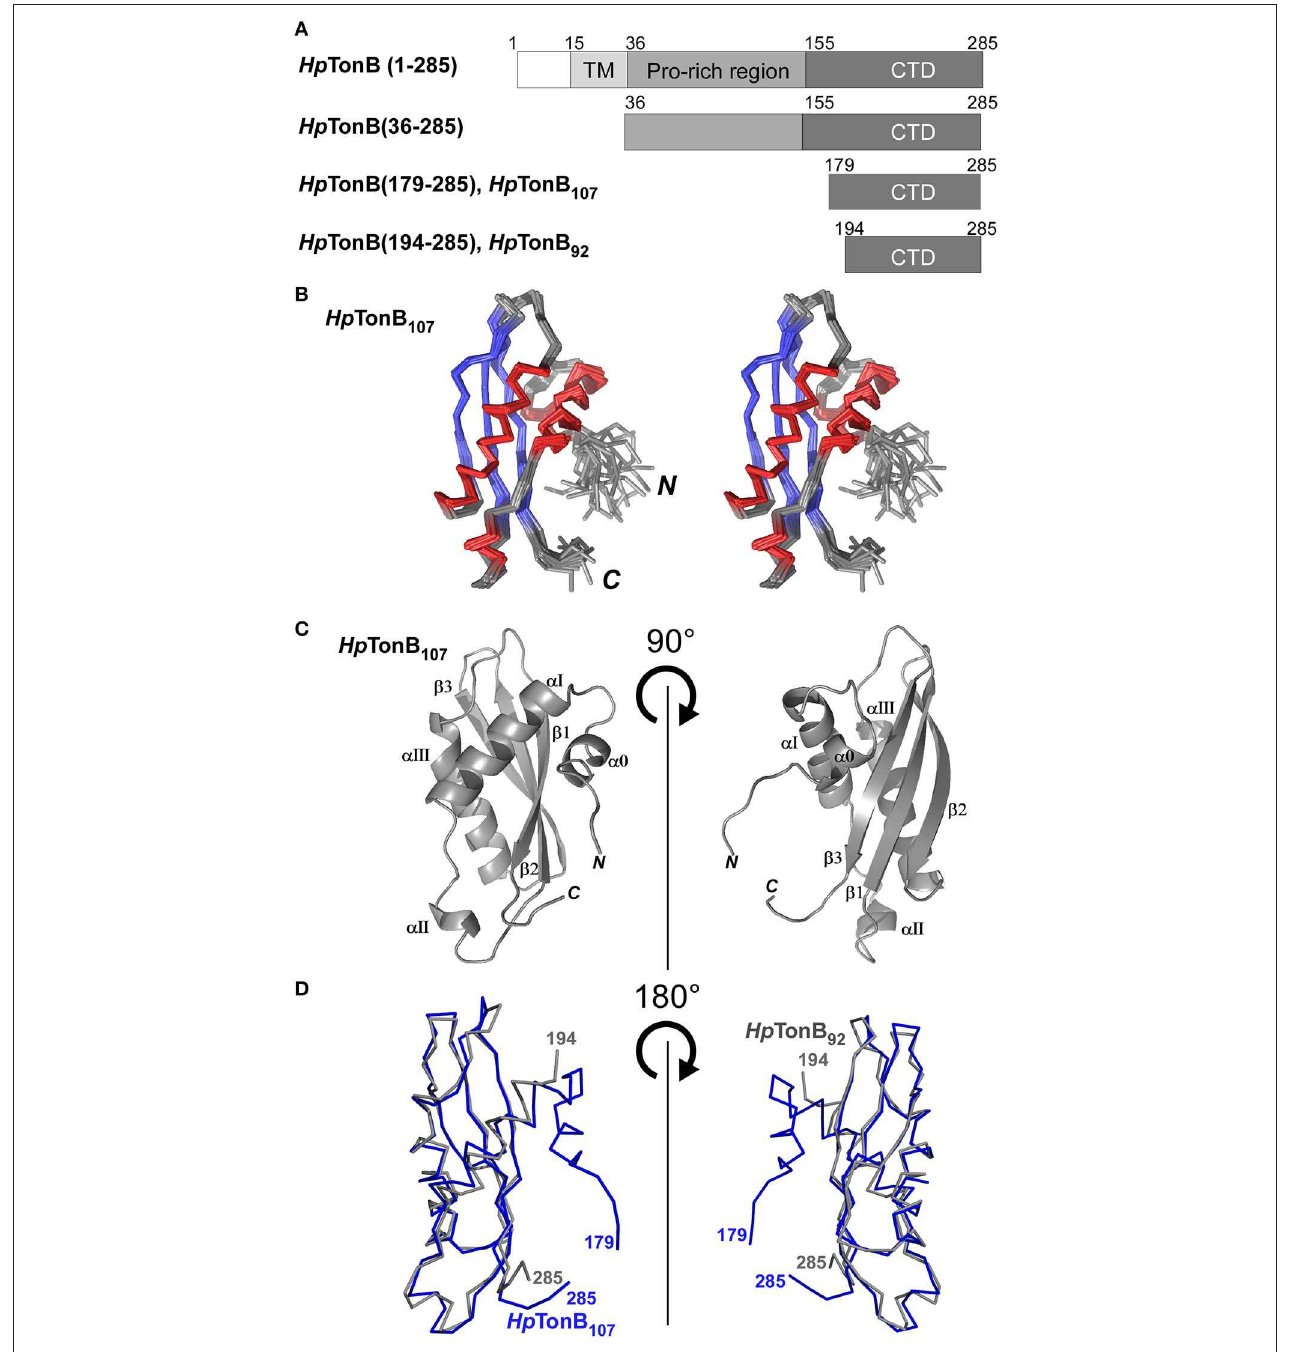
FIGURE 2 | NMR solution structure of Hp TonB 107 (A) Schematic representations of the domain organization of the full-length TonB and dissected Hp TonB variants used in this study. (B) A stereo-view of an ensemble of the 20 NMR-refined conformers of Hp TonB 107 . The regions for α -helices and β -sheets are colored in red and blue, respectively. (C) Cartoon drawings of the Hp TonB 107 structure with the secondary structure elements labeled. (D) A superposition of the two NMR structures of Hp TonB 107 (in blue) and Hp TonB 92 (in gray). The residue numbers for the termini are shown.